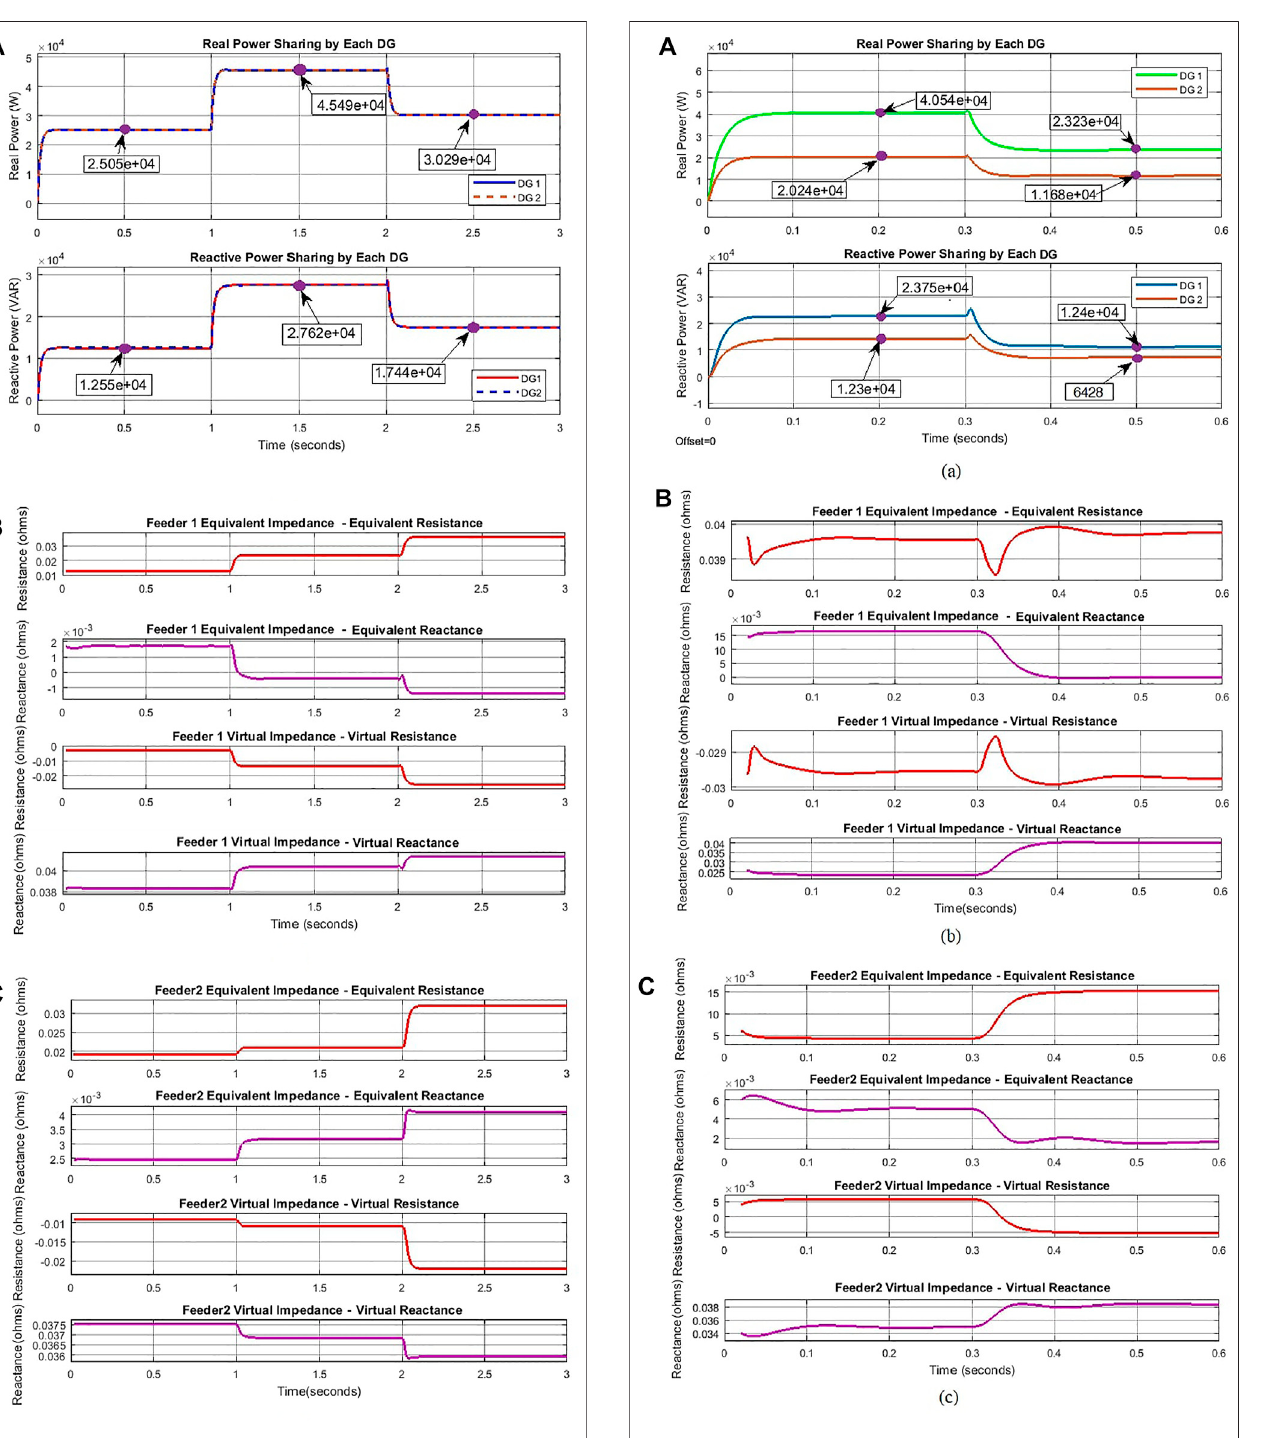
FIGURE 4 | Simulation results for EQUAL DG RATING: (A) power sharingbyDGs, (B) equivalentimpedanceandvirtualimpedanceofline1,and (C) equivalent impedance and virtual impedance of line 2.